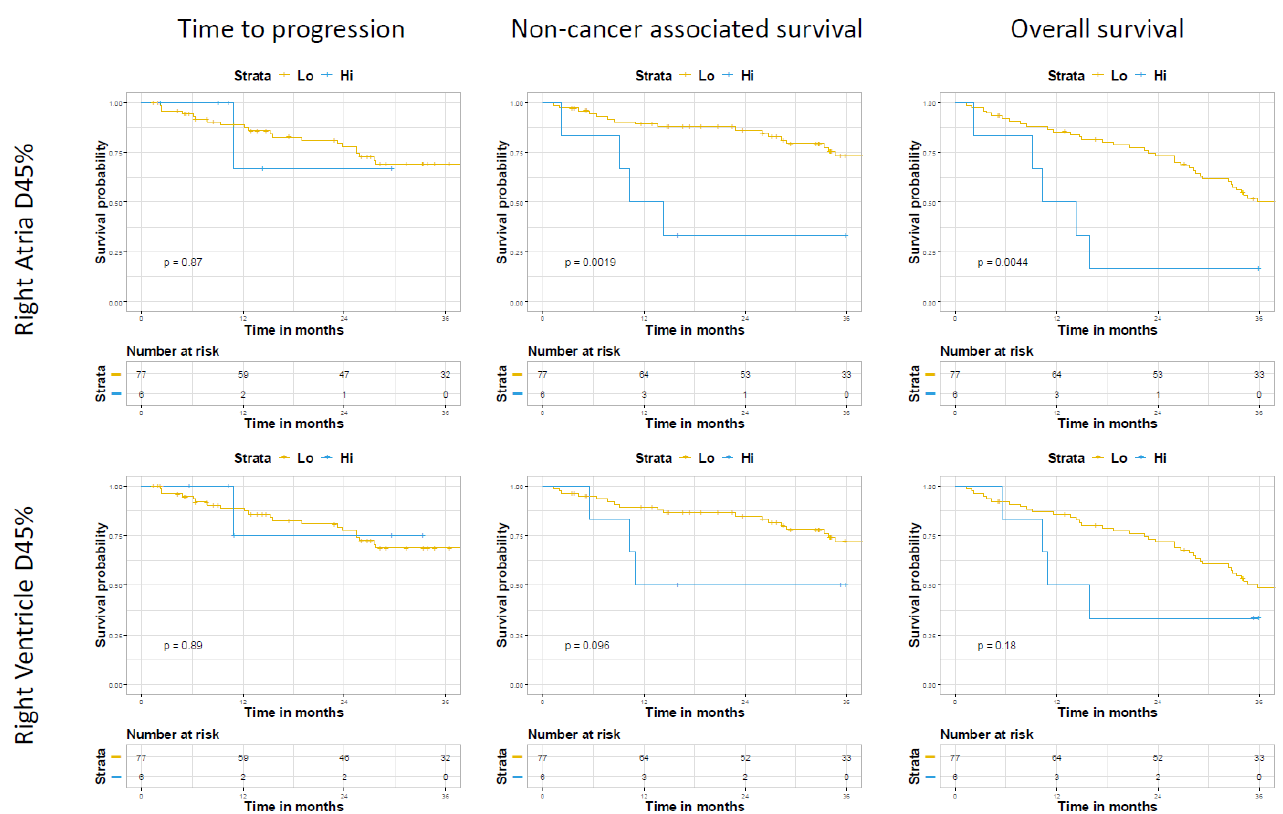
Figure 2. Associations between selected the cutoff values for right atria ( top ) and ventricle ( bottom ) D45% and relevant outcomes by Kaplan